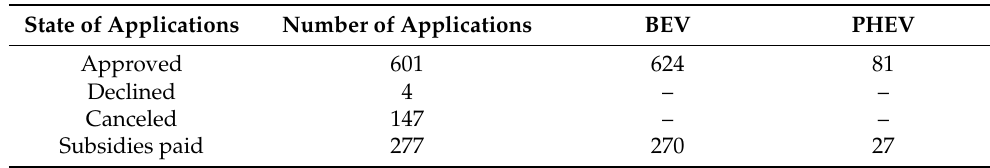
Table 8. Overview of subsidy applications for BEV and PHEV in 2019. Results of scan cycle times for monitored days. Source: [45].